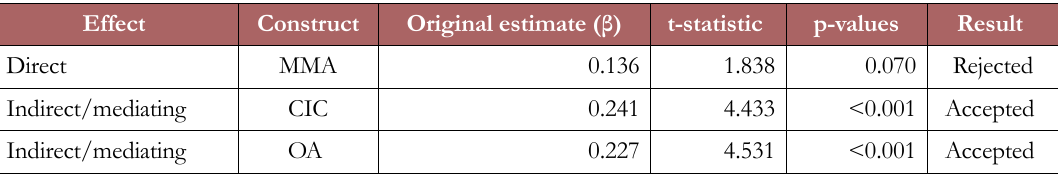
Table 5. Hypothesis test